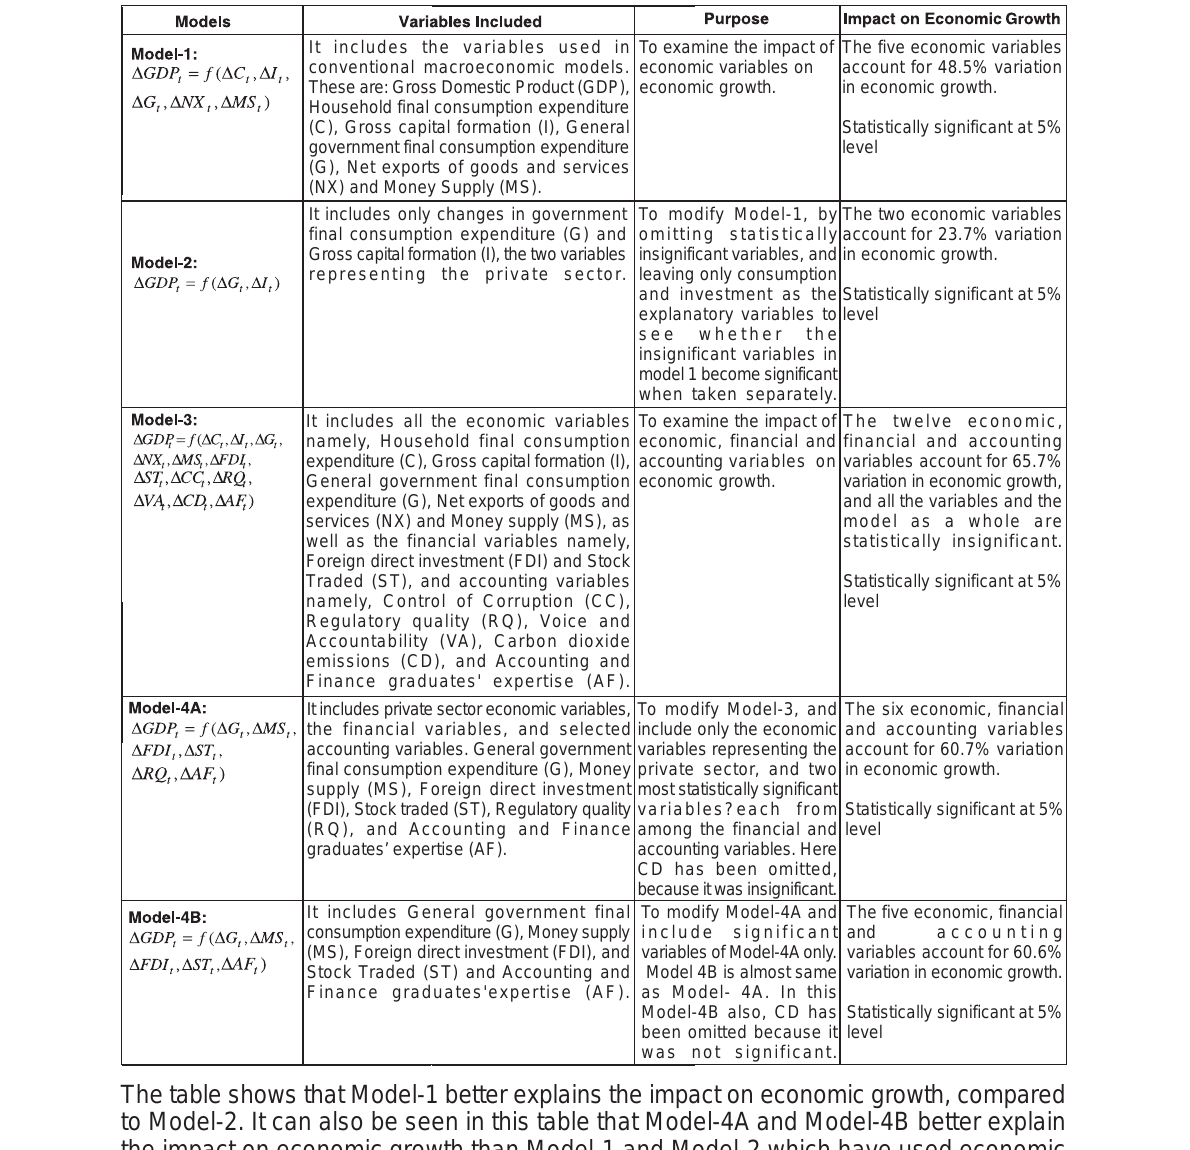
Table-1: The Proposed Models and their Effect on Economic Growth It includes the variables used in conventional macroeconomic models.These are: Gross Domestic Product (GDP),Household final consumption expenditure (C), Gross capital formation (I), General economic government final consumption expenditure